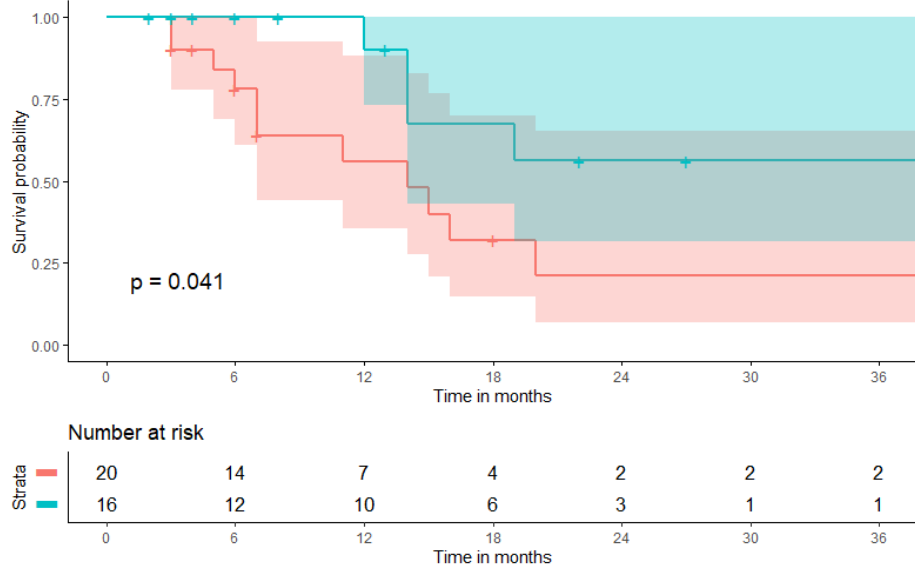
Figure 5. Kaplan-Meier curve depicting overall survival (OS) with confidence interval estimates at the timepoint of pembrolizumab therapy initiation broken down by pretherapeutic body mass index. The blue line depicts the cohort with a pretherapeutic BMI ≥ 25 kg/m 2 , the red line depicts the cohort with a pretherapeutic BMI < 25 kg/m 2